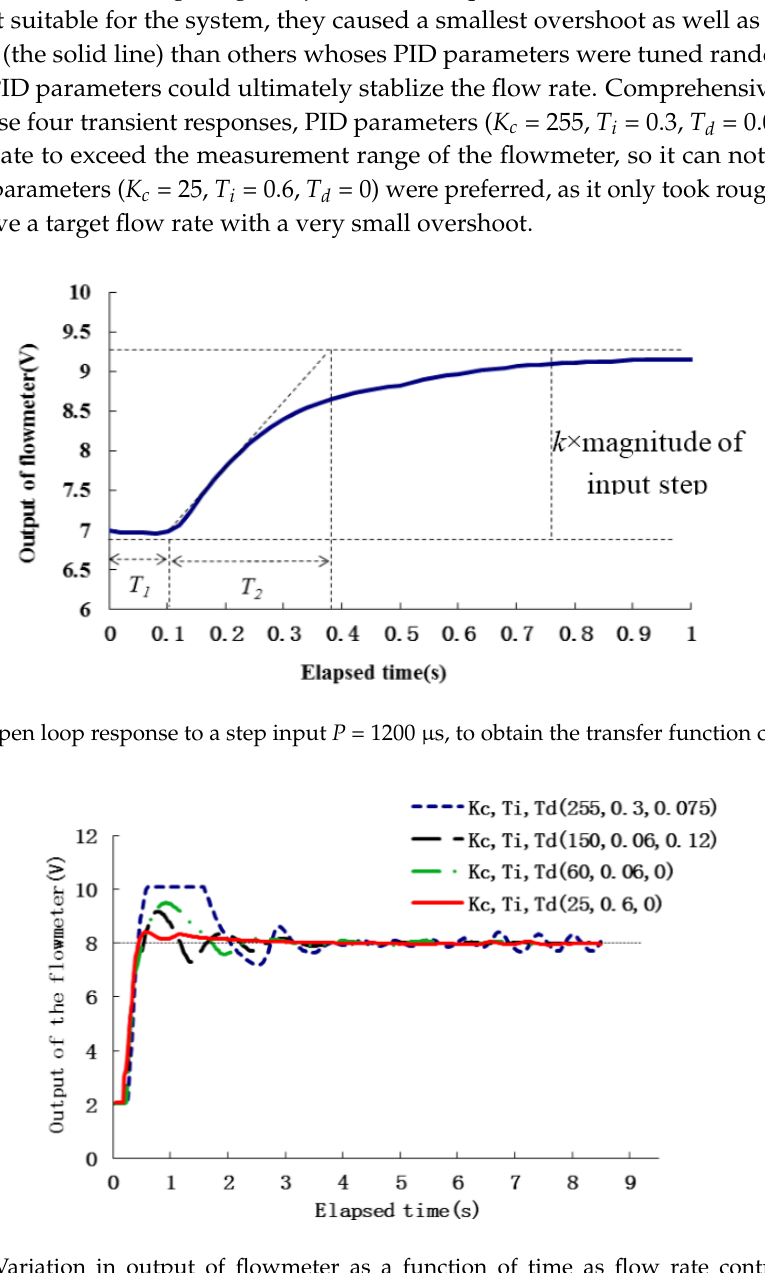
Figure 9. Variation in output of flowmeter as a function of time as flow rate controlled with four groups of different PID parameters, the set-point flowmeter = 8 V (equivalent to chemical flow rate = 11.8 mL/min).